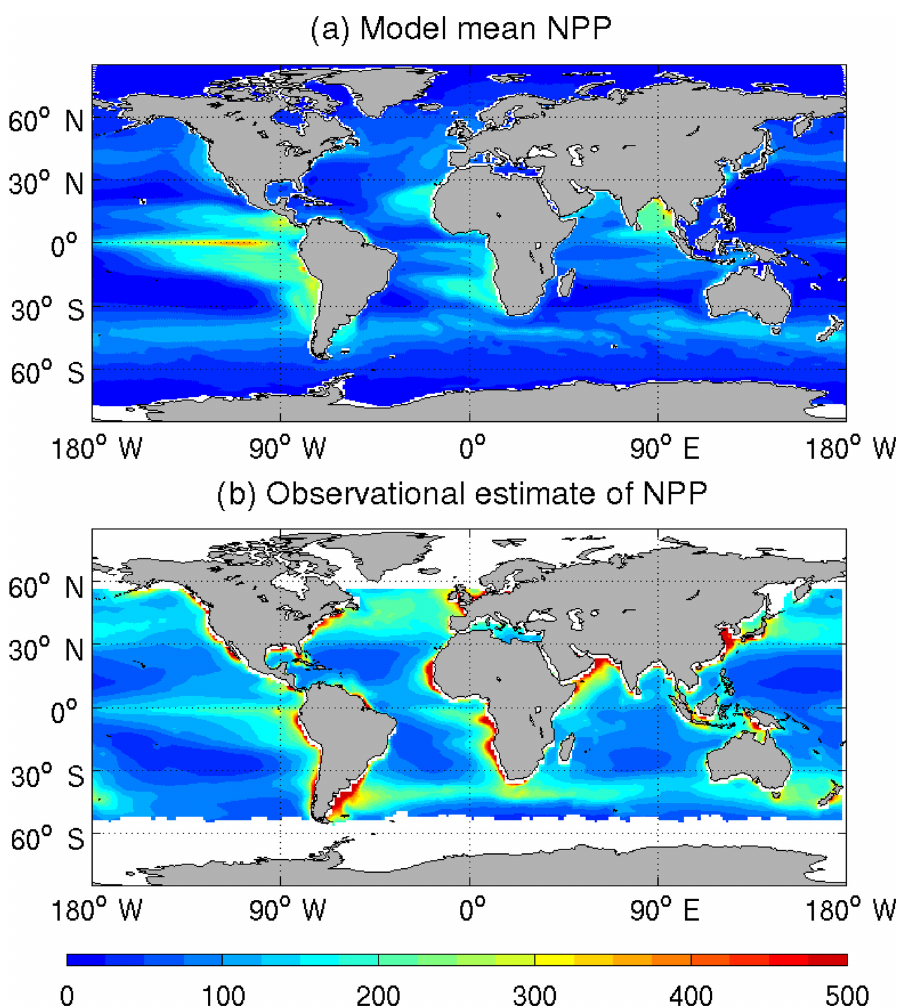
Figure 9. Spatial distribution of annual mean ocean primary production from (a) model and (b) observations. The observational estimate is based on remotely sensed chlorophyll data and the Vertically Generalized Production Model (VGPM) from Behrenfeld and Falkowski (1997). Model value is taken from the last 50 years of the PI control period. Units are in gCm − 2 yr − 1